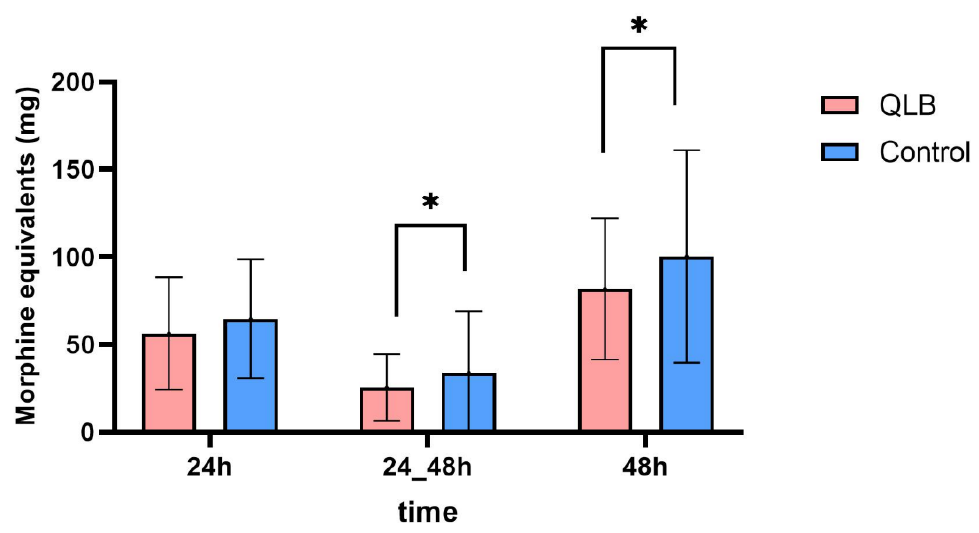
Figure 3. Postoperative opioid consumption during the 48 h postoperative period between the QLB and control group. Values are mean ± SD. * p < 0.05 QLB, quadratus lumborum block. Resting, mean, and worst pain scores compared with preoperative values were signif- icantly lower in the QLB group during the 48 postoperative period (Figure 4) ( p = 0.041, 0.007, and 0.020 respectively). Pain scores and difference of resting pain compared to preop- erative pain scores for each group at different time points are shown in the supplementary materials (Table